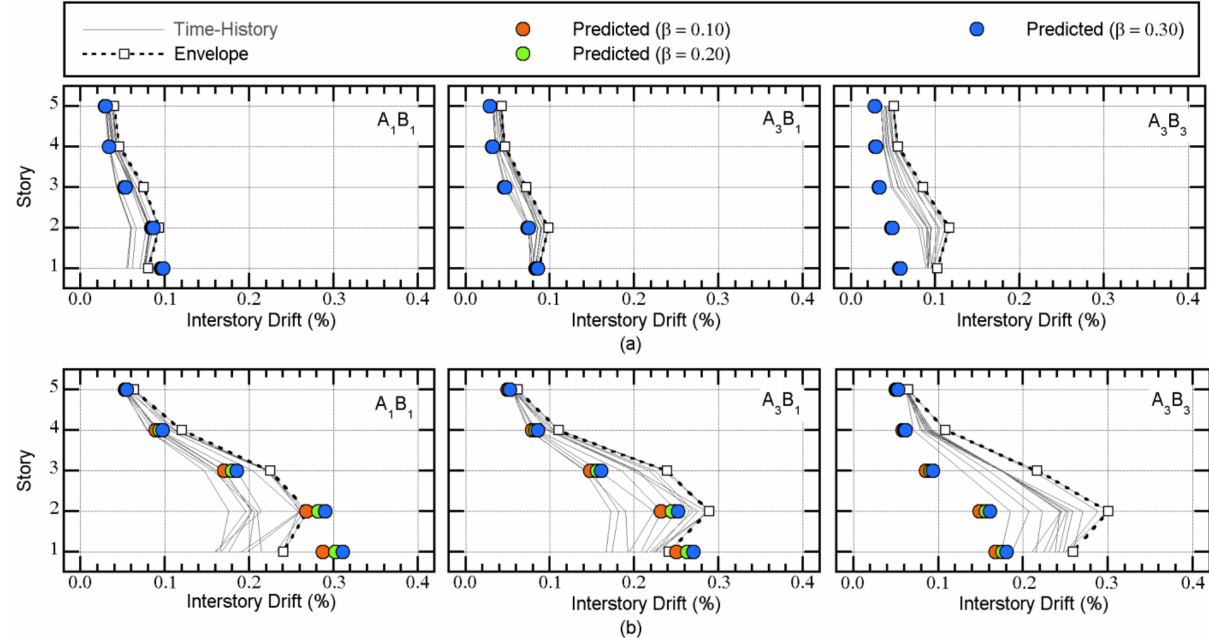
Figure 27. Comparison of the peak drift for the columns (Model-Tf34) with ( a ) UTO0414 and ( b )